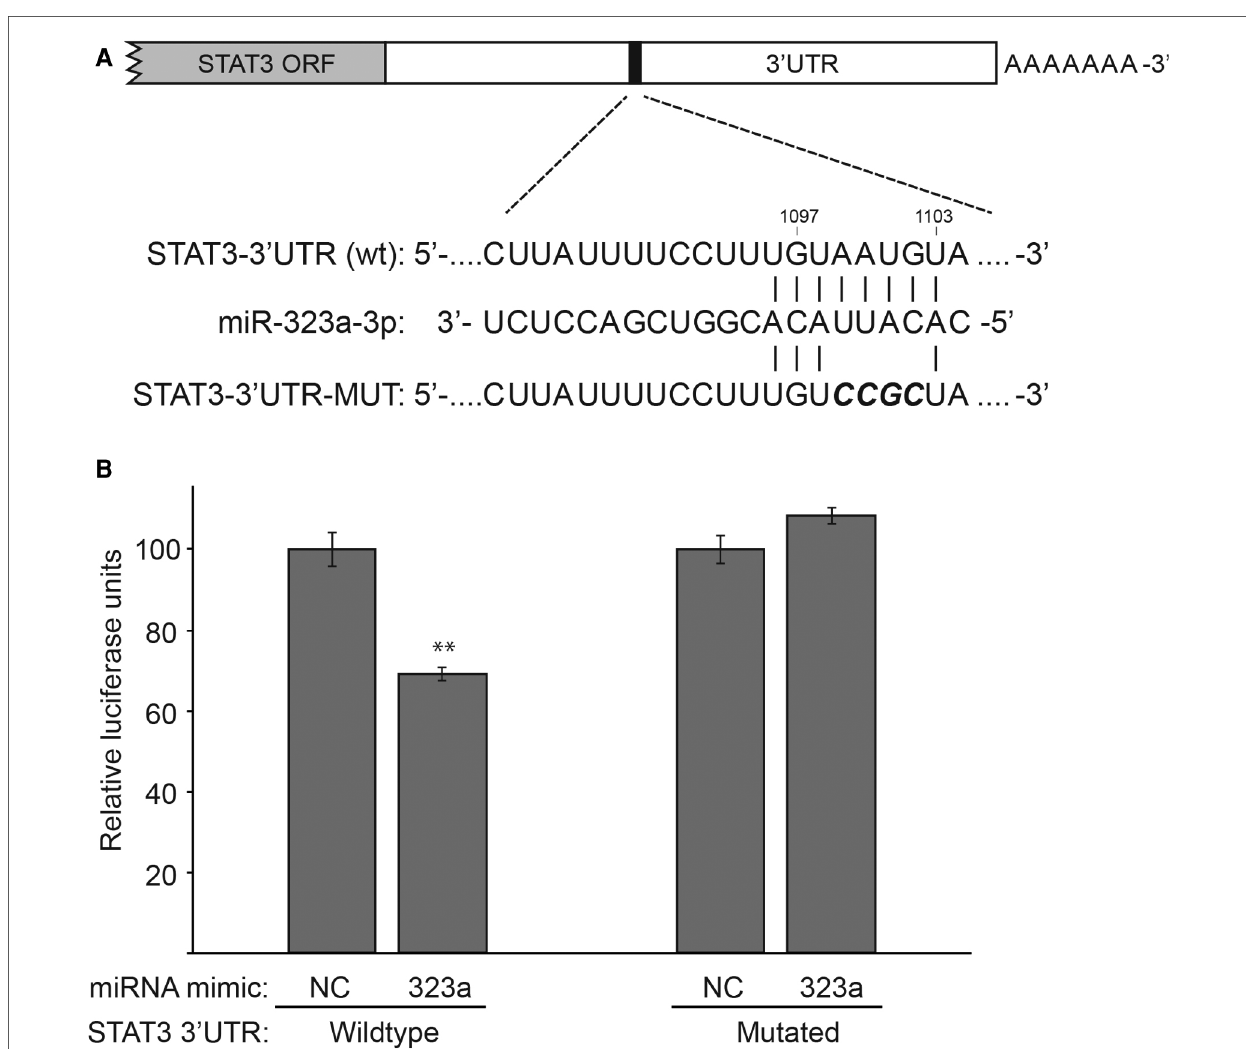
FIGURE 4 STAT3 is a direct target of miR-323a-3p in neuroblastoma. ( A) The putative binding site of miR-323a-3p (nucleotides 1,097 to 1,103) in the 3 ′ UTR of STAT3 was mutated as shown in the fi gure with bold and italics. (B) Dual-luciferase reporter assay demonstrating the luciferase activity of a construct with a wild- type or a mutated 3 ′ UTR of STAT 3 in SH-SY5Y transfected with miR-323a-3p or NC mimics. Data is presented as mean±SD of three independent experiments, each repeated in triplicates. ** P <0.01 vs. the NC. SD, standard deviation; miR, microRNA; NC, negative control; STAT3, signal transducer and activator of transcription; ORF, open Reading frame; UTR, untranslated region; wt, wild-type; MUT,